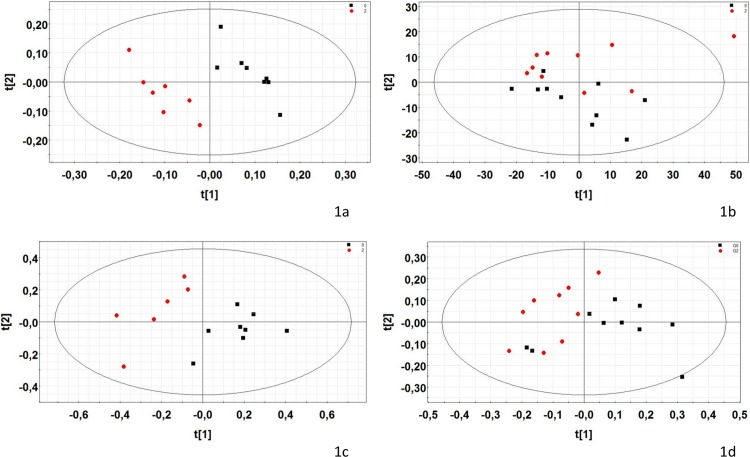
Two-dimensional PLS-DA and PCA scores plot of pregnant rat samples integrated 1H NMR spectra.1a: GD 15 urine samples (PLS-DA, A = 2, R2 = 94.8%, Q2 = 0.613); 1b: GD 21 plasma samples (PCA, A = 4, R2 = 72.5%); 1c: GD21 liver aqueous extract samples (PCA, A = 3, R2 = 61.6%); 1d: GD21 brain aqueous extract samples (PCA, A = 4, R2 = 72.8%). Each dot represents an observation (animal), projected onto first (horizontal axis) and second (vertical axis) PLS-DA or PCA variables. Control group is shown with black squares and the group exposed to eight pesticides widely used in Brittany (France) in 2004 (acetochlor, bromoxynil, carbofuran, chlormequat, ethephon, fenpropimorph, glyphosate, imidacloprid) is shown with red circles. The black ellipse determines the 95% confidence interval, which is drawn using Hotelling’s T2 statistic.